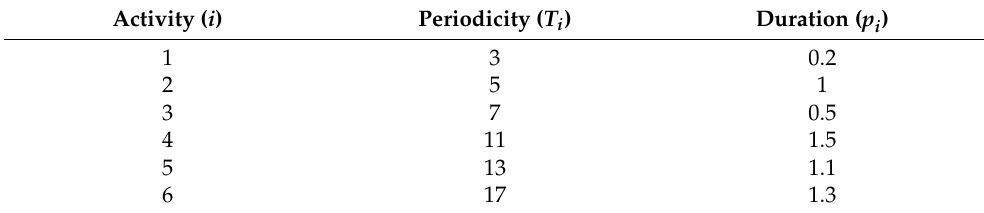
Table 1. Instance parameters.